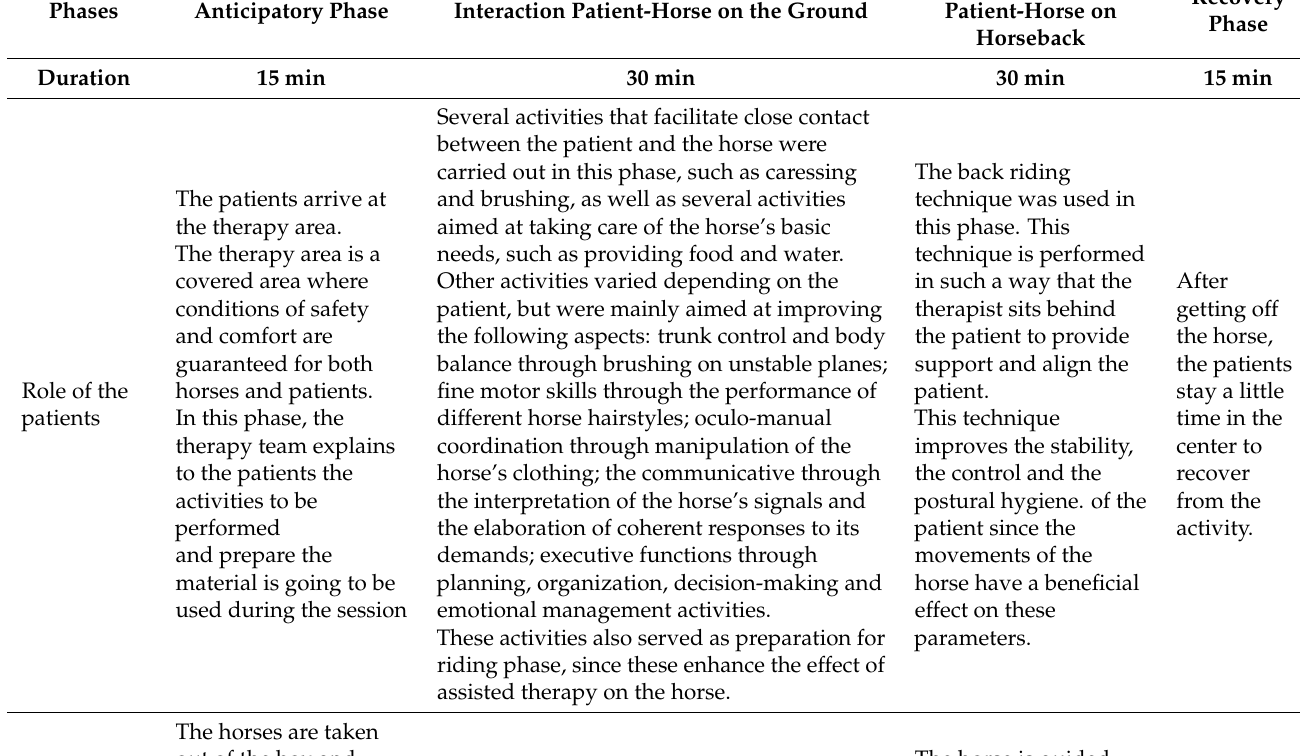
Table 3. Phases of the equine assisted therapy sessions: duration, role of horses and patients, and data collection.